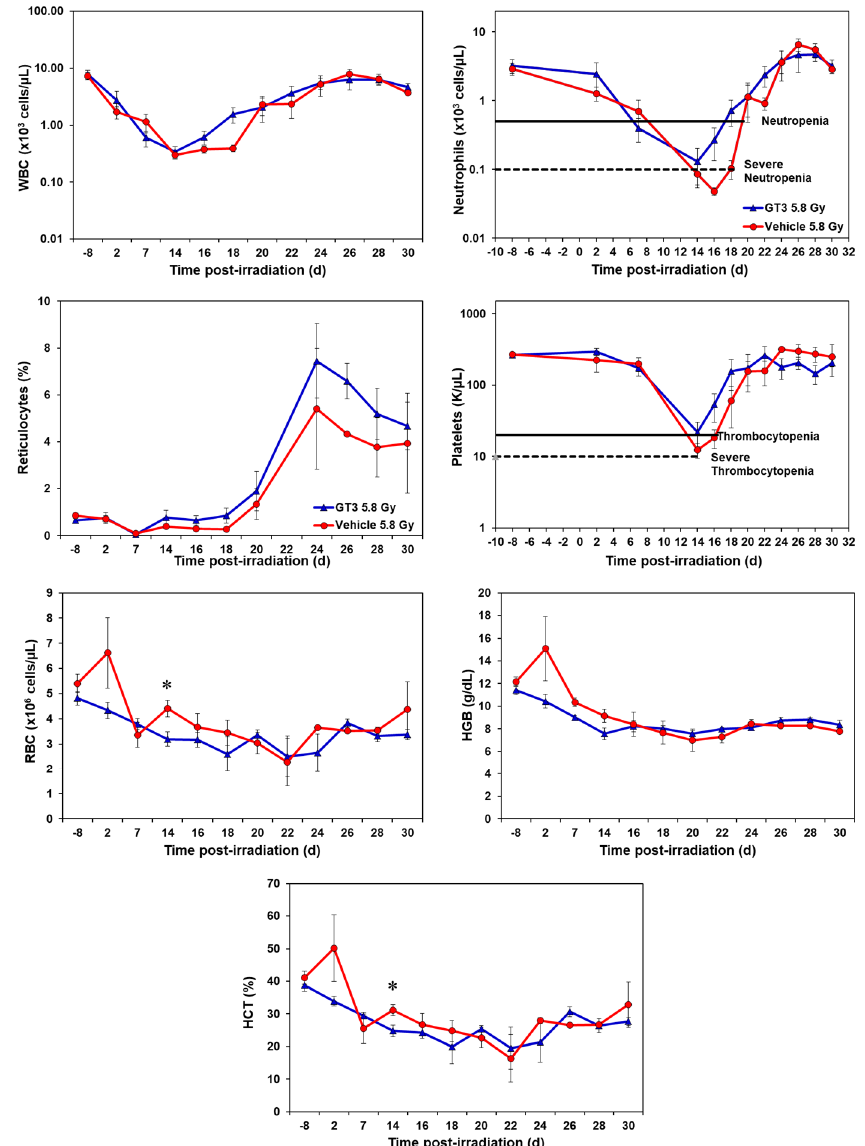
Figure 2. Effects of GT3 on complete blood count (CBC) in NHPs exposed to 5.8 Gy TBI. NHPs received GT3 (37.5 mg/kg) or vehicle 24 h prior to irradiation. Peripheral blood was collected at various time points. Cells were counted utilizing a Bayer Advia-120 cell counter. Data are expressed as mean ± SEM. * The difference between GT3- and vehicle-treated groups was significant when equal variance between groups was assumed (* p < 0.05).